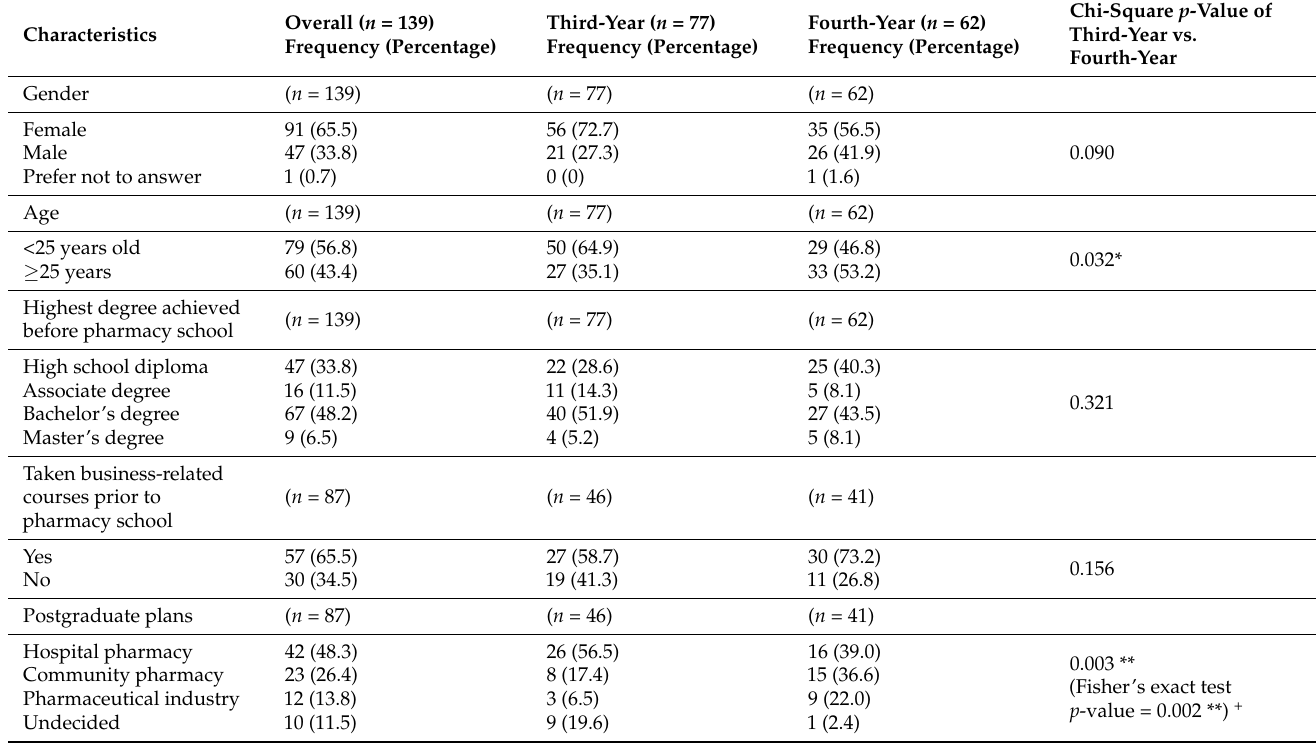
Table 2. Demographic characteristics of Third- and fourth-year Pharmacy Student